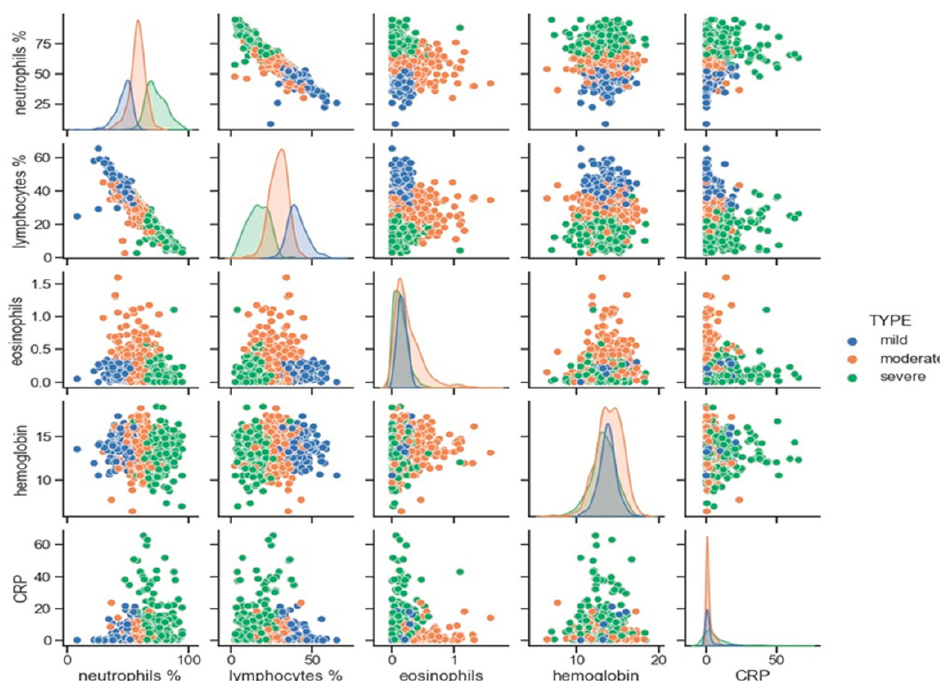
Figure 3. Diagonal plots represent the distribution of the target variable across the three patient clusters. The distribution of the individual values in pairs of variables for the three clusters are represented in scattered plots. Three clusters of patients: blue, light brown, and green represent mild, moderate, and severe bronchiectasis patients, respectively.